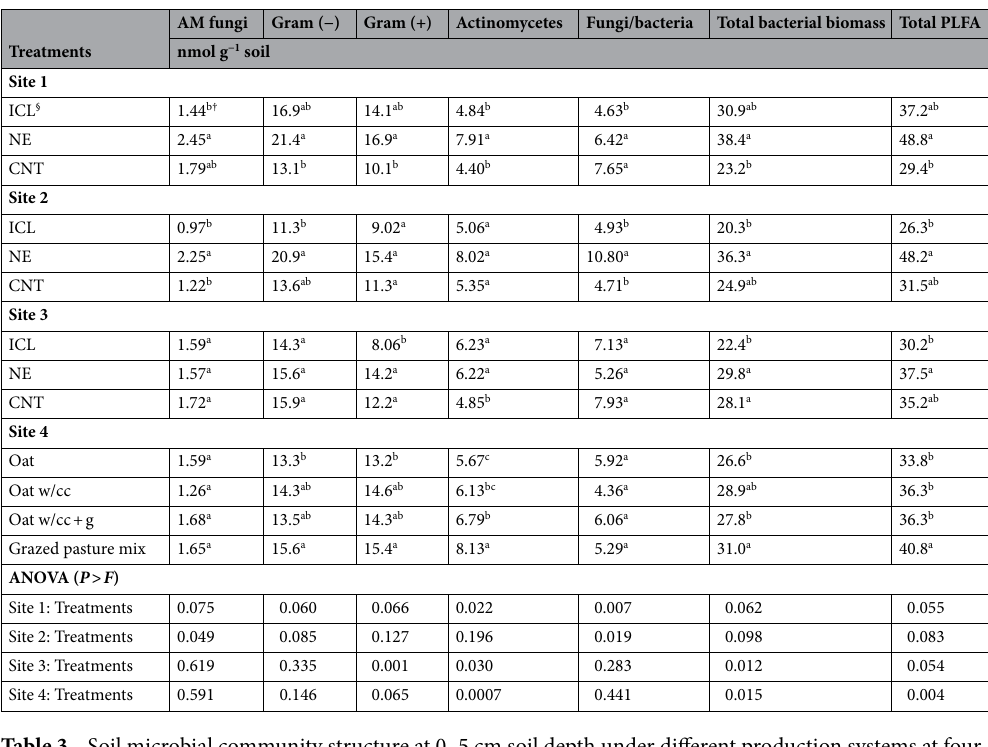
Table 3. Soil microbial community structure at 0–5 cm soil depth under different production systems at four different sites. § ICL integrated crop–livestock, NE natural ecosystem, CNT control, CC cover crop, g grazing. † Means followed by different letters within a column under each site are significantly different at P ≤ 0.05 according to Fisher’s LSD.